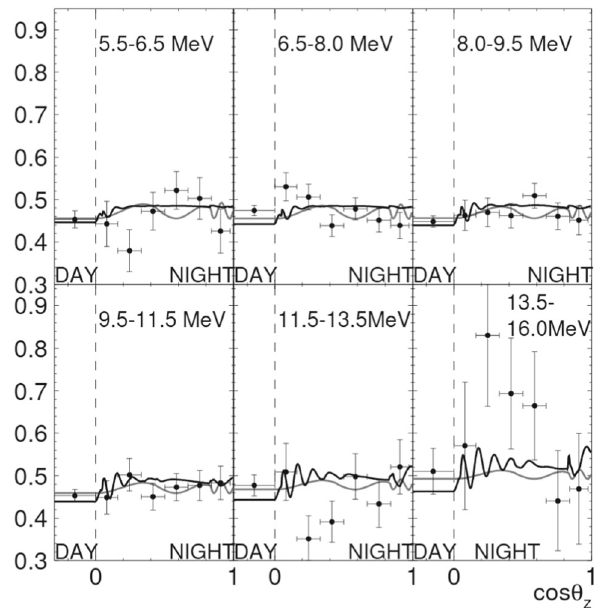
Fig. 1 Datafrom the1496 days ofSuper-Kamiokande. Eachday/night plot gives a binning in energy, LOW (light gray) and LMA (black) pro- posed solutions to be visually compared to data points. Taken from